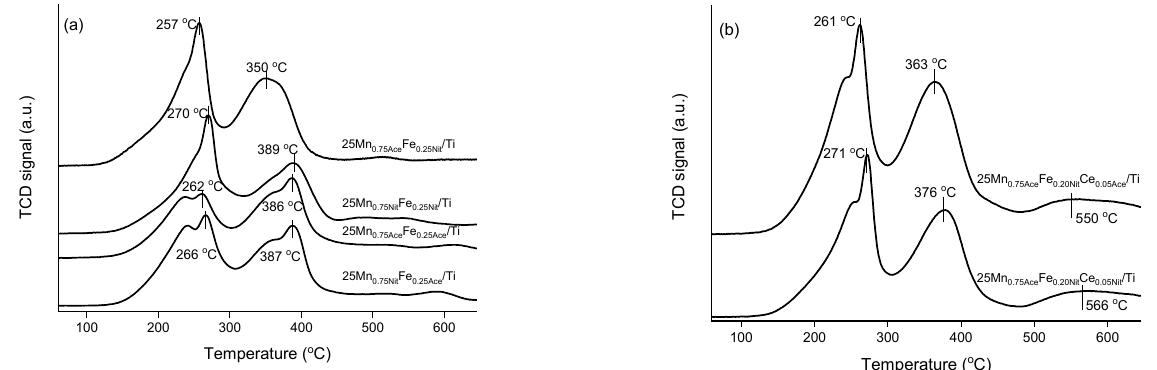
Figure 5. H 2 -TPR (temperature-programmed reduction with hydrogen) profiles of ( a ) 25MnFe/Ti and ( b ) 25MnFeCe/Ti catalysts. The 25Mn 0.75Ace Fe 0.25Nit /Ti, 25Mn 0.75Nit Fe 0.25Nit /Ti, 25Mn 0.75Ace Fe 0.25Ace /Ti, and 25Mn 0.75Nit Fe 0.25Ace /Ti catalysts consumed 4120, 4004, 3996, and 3972 µ mol/g of H 2